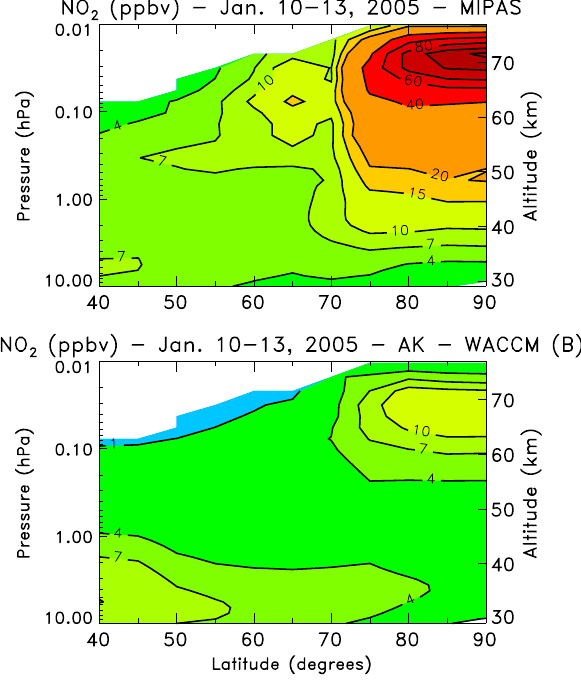
Fig. 9. Envisat MIPAS NO 2 measurements (top) and WACCM3 B average (bottom) for the four-day (10–13 January 2005) average in the Northern Hemisphere. The MIPAS averaging kernel (AK) was used to sample the WACCM3 results. The contour intervals are 1, 4, 7, 10, 15, 20, 40, 60, 80, 100, and 120ppbv.